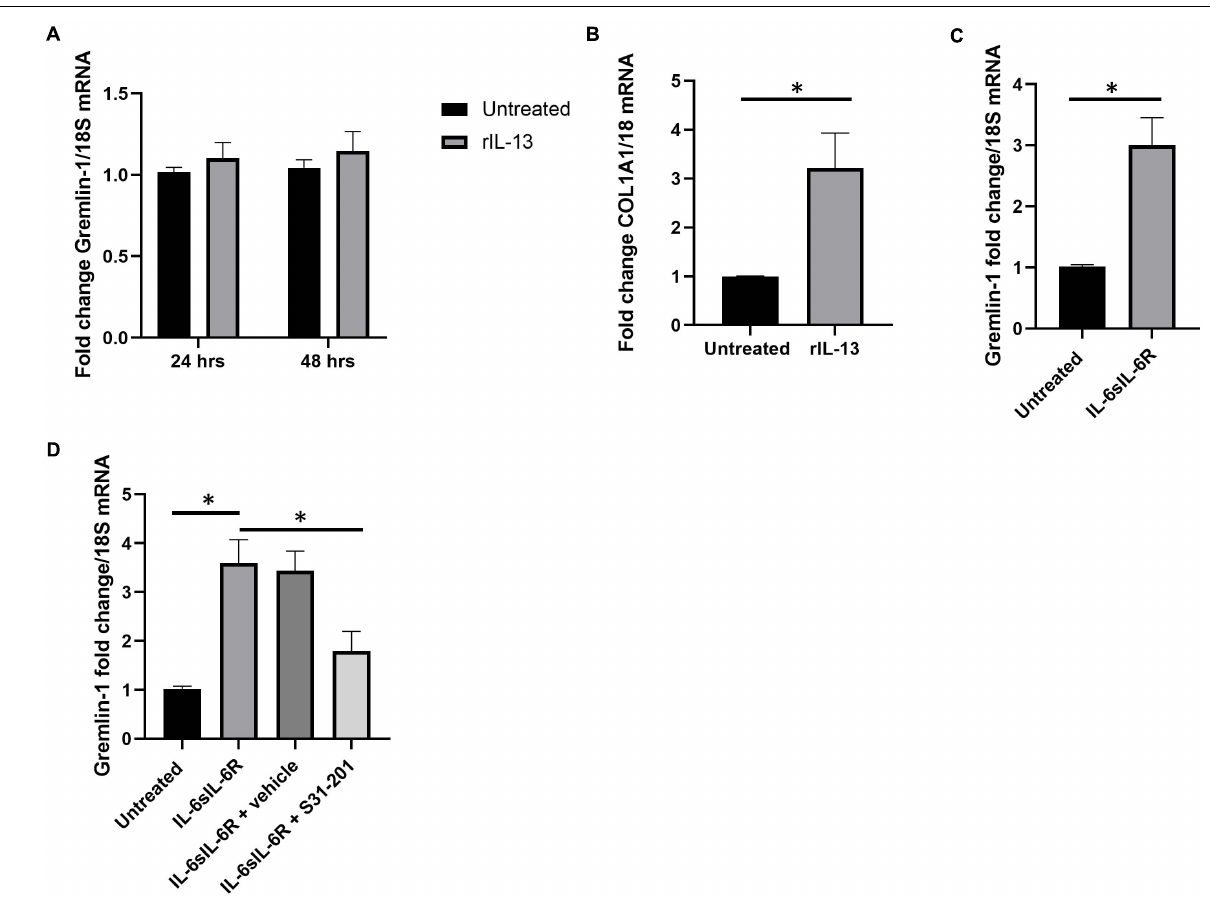
FIGURE 8 | IL-6 but not IL-13 or IL-11 mediates Gremlin-1 upregulation. (A) Gremlin-1 expression in healthy dermal fibroblast after stimulation with recombinant IL-13 at 24 and 48 h time points. Data is mean and SD and is normalized to 18S expression and shown as fold change to untreated cells. (B) COL1A1 gene expression is elevated after IL-13 incubation Data is mean and SD and is normalized to 18S Data is the mean and SD . (C) Gremlin-1 gene expression after IL- trans signaling. Data is the mean and SD and is normalized to 18S and shown as fold change. ∗ P = 0.0015; Student’s t -test n = 3. (D) Gremlin-1 gene expression was quantified by qPCR. Cells were treated with IL-6 and sIL-6 receptor or the STAT3 inhibitor S31-201. Cells were lysed and qPCR performed. Data is the mean and SD and is normalized to 18S and set as fold